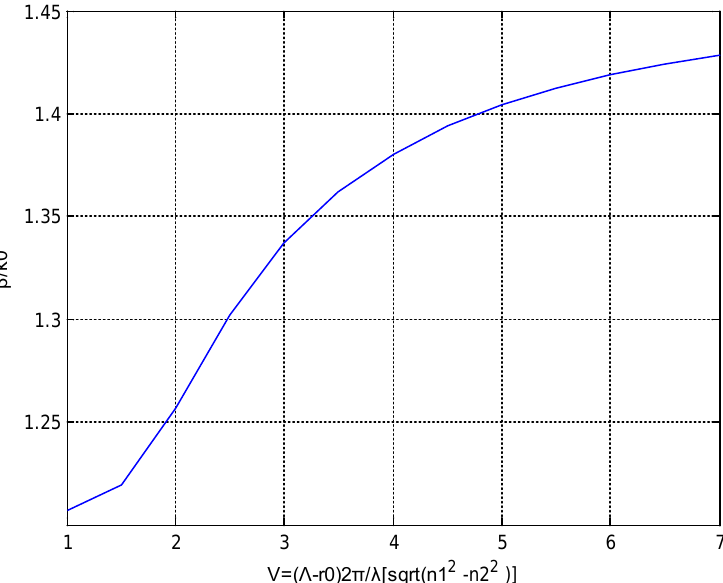
Figure 11. β /V diagram of the even fundamental for a PCF.